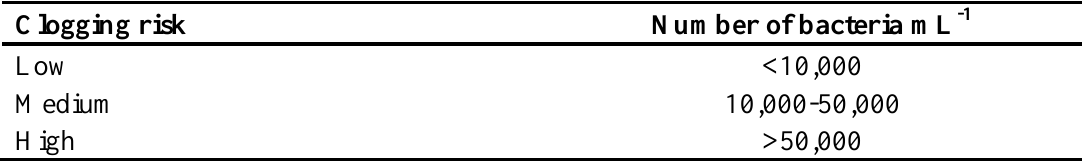
Table 1. Effects of bacterial concentration on clogging risk [27].